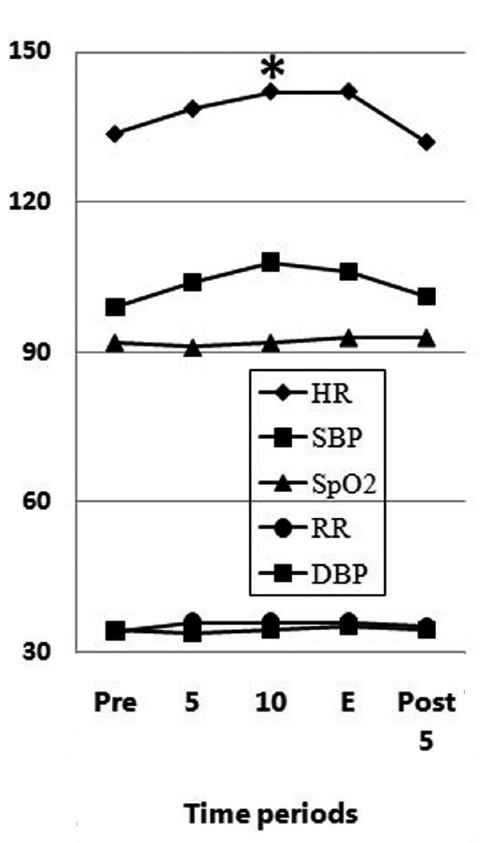
Fig. 2 – Changes SBP, DBP, H, SpO , and RR during physiotherapy in 2 18 children after cardiac surgery. Data represent mean. *Significantly different from Pre Time